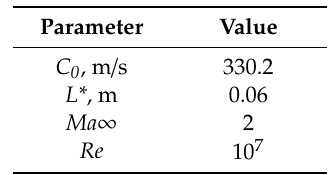
Table 2. Input parameters for the proposed numerical